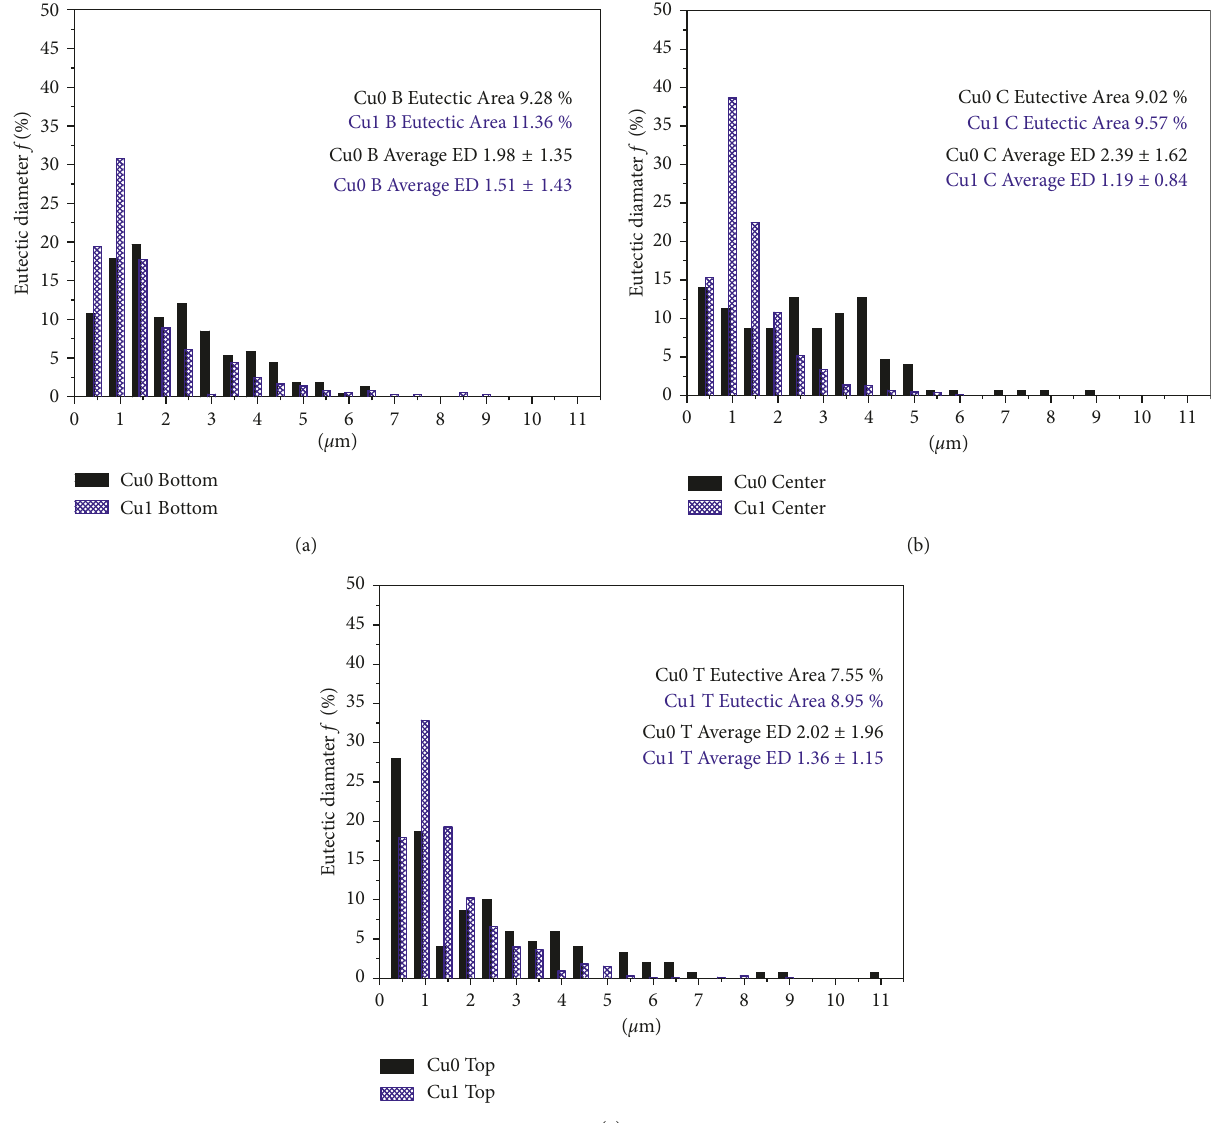
Figure 5: Distribution of the eutectic Si particles’ equivalent diameter. Comparison between Cu-free and Cu-containing alloys (1 wt.% Cu) in the three bottom (a), center (b), and specimen (c) cutting